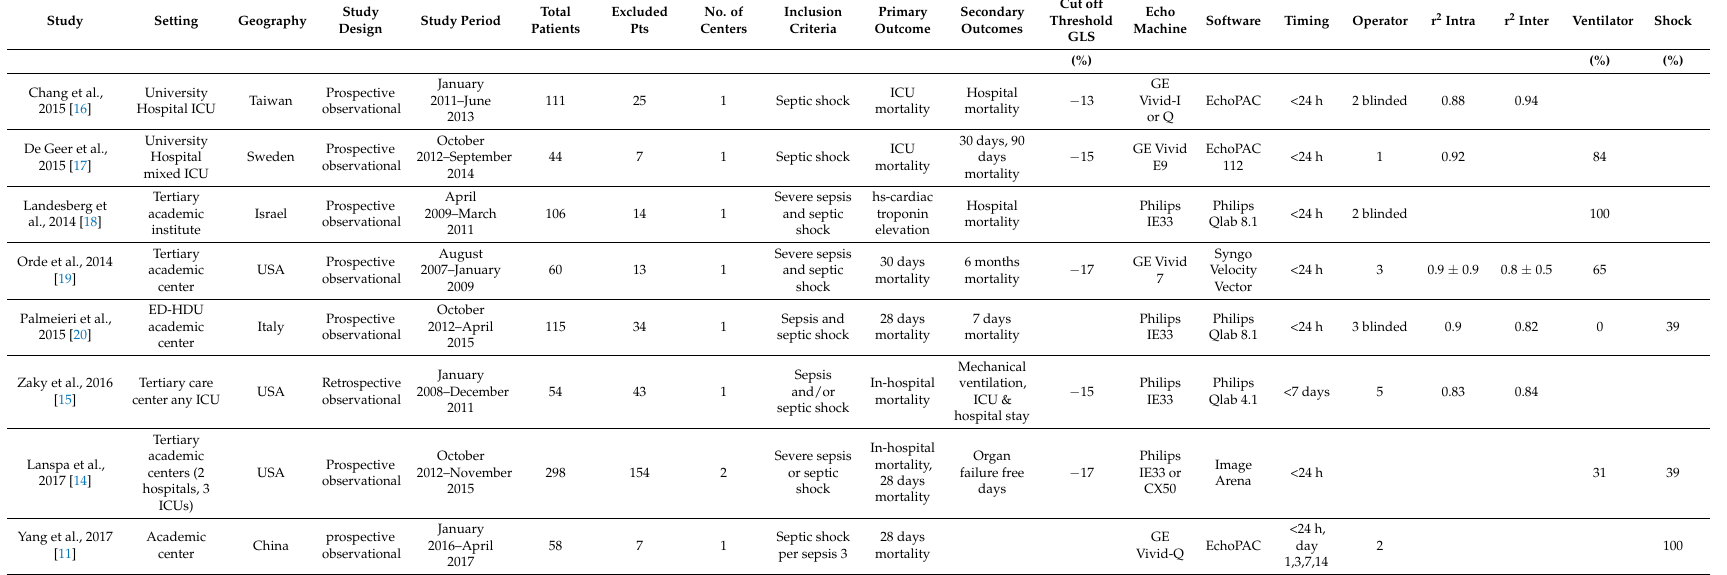
These published studies utilized different strain analysis software and echo imaging platforms (Table 1): Philips Qlab 8.1 ® was utilized in 3 studies ( n = 352), EchoPACS ® in 3 studies ( n = 213), Image Arena ® in 1 study ( n = 298) and Syngo Velocity Vector ® ( n = 60). Philips IE 33 ® was used for Image acquisition in 4 studies ( n = 573) and GE Vivid ® in 4 studies ( n = 273). The end points reported were heterogeneous and variable (Table